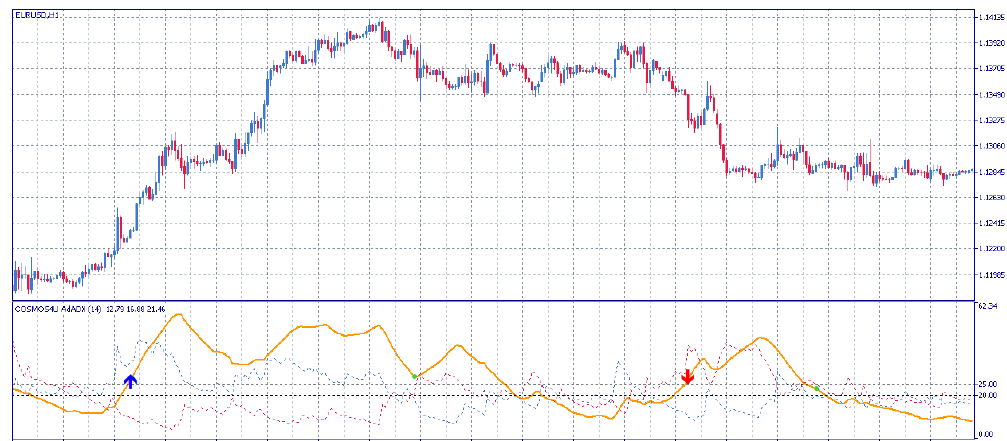
Figure A4. EUR/USD chart with signals from the AdADX strategy